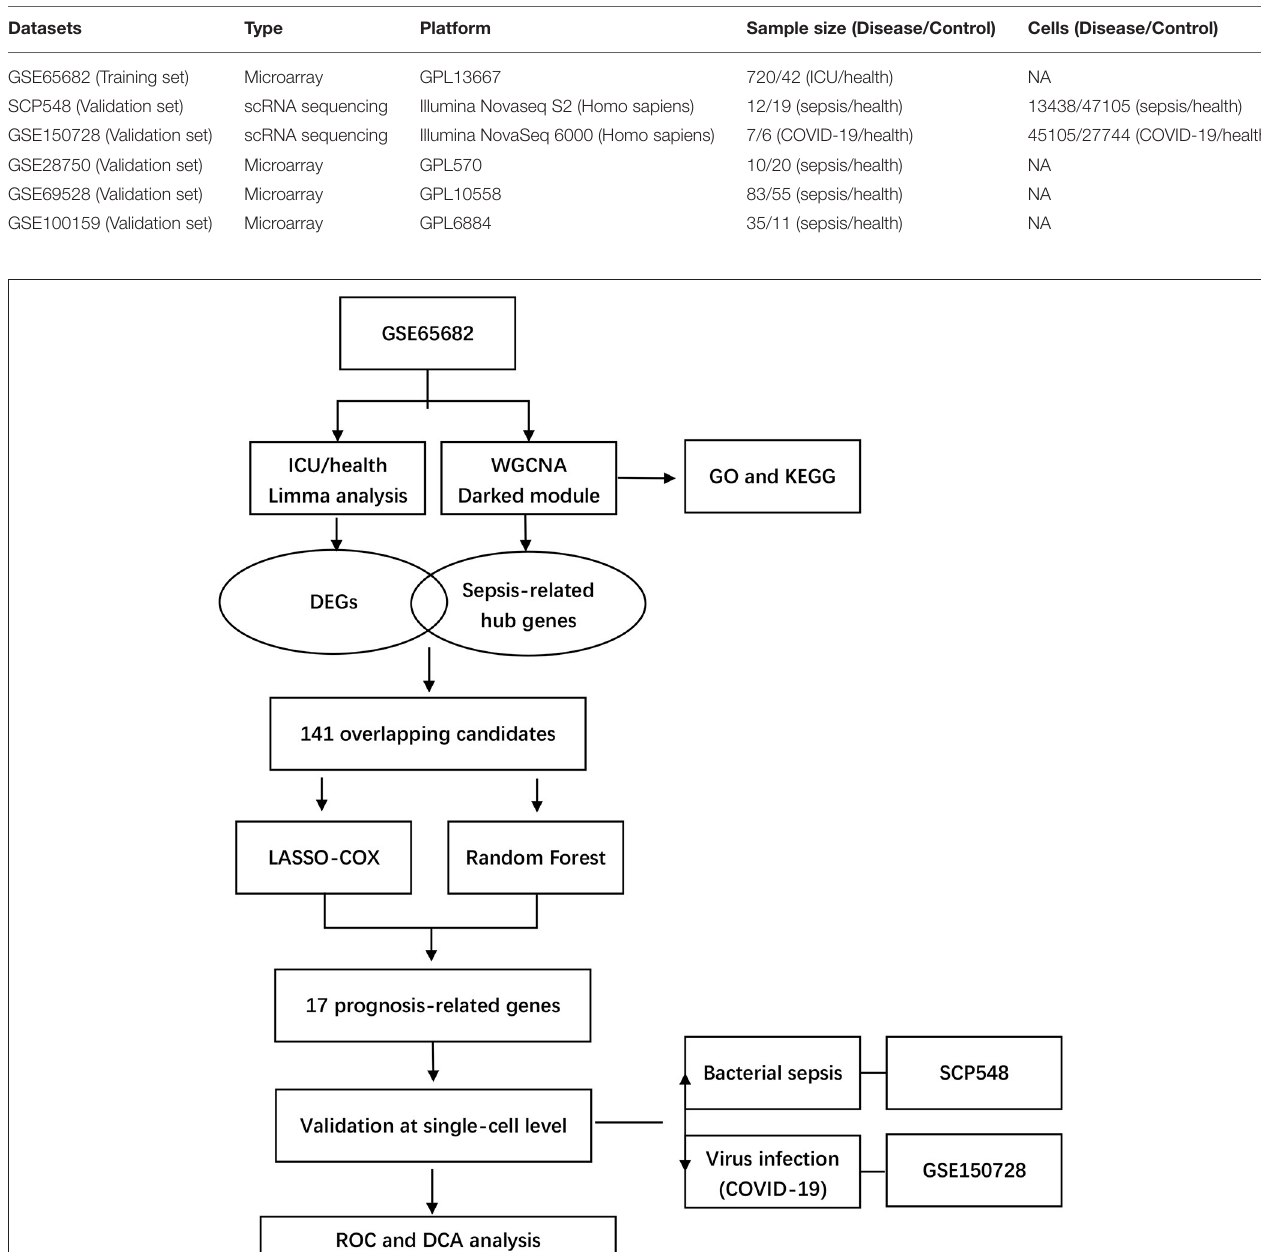
TABLE 1 | Information for selected datasets in this study.